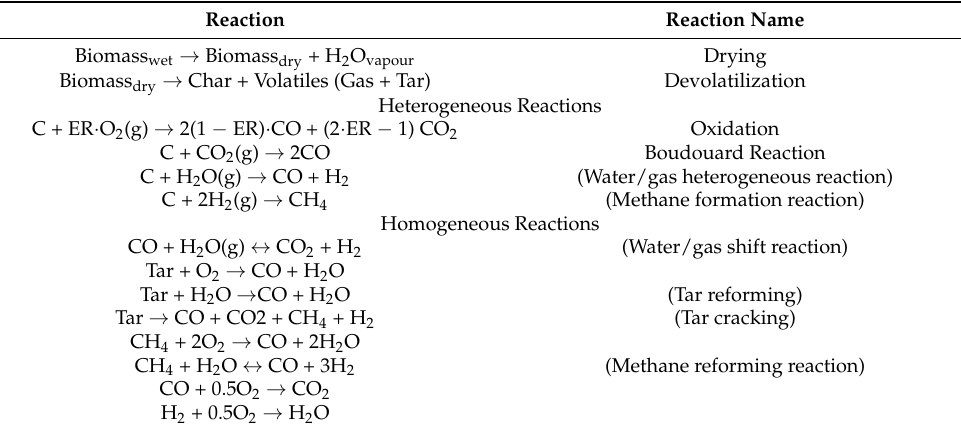
Table 1. Reactions occurring in a downdraft